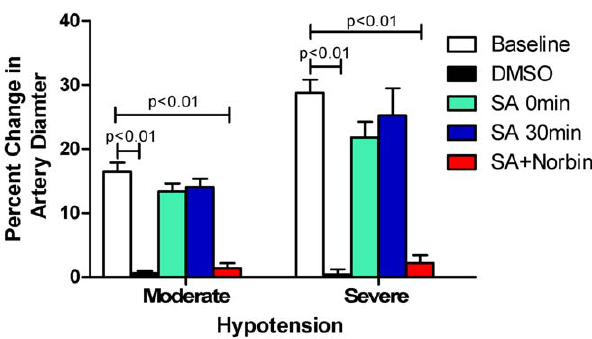
Figure 2. Effects of post HI salvinorin A administration on pial artery dilation to hypotension. HI with DMSO damaged dilation of pial artery to hypotension. SA administrated at onset and 30 min after HI preserved the dilations of pial artery to moderate and severe hypotension, which were blunted by co-administration of norbinaltor- phimine (Norbin). Percentage change= (diameter after hypotension– diameter before hypotension)/diameter before hypotension)*100. N=5 in each group. SA: Salvinorin A. Moderate: 25% decrease of mean blood